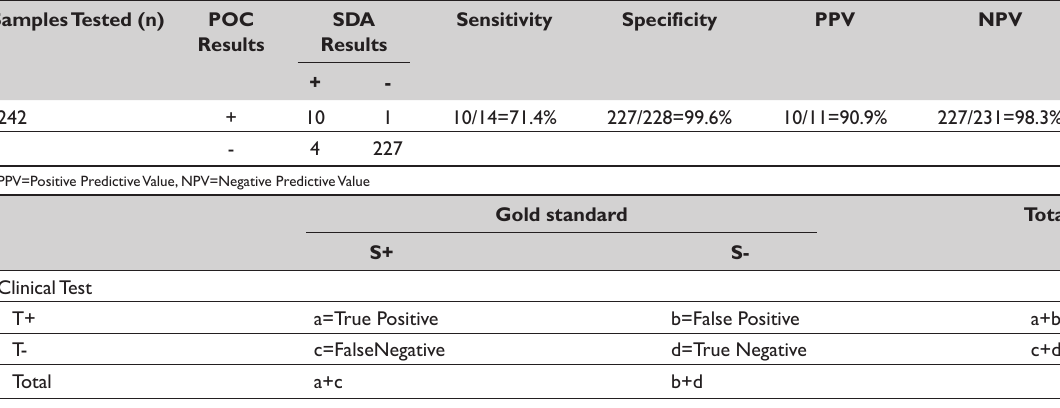
Table 2: Performance of Cortez OneStep Chlamydia RapiCard TM insta test Samples Tested